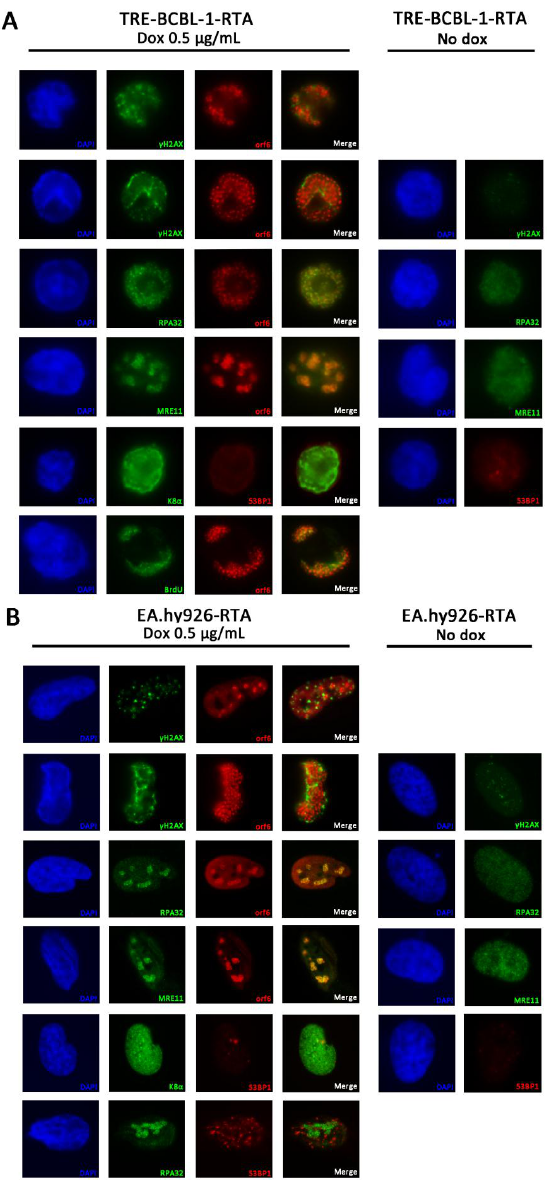
Figure 6. Localisation of DDR proteins during lytic replication of KSHV. ( A ) Localisation of γH2AX, RPA32, MRE11 and 53BP1 in TRE-BCBL-1-RTA cells 24 h following addition